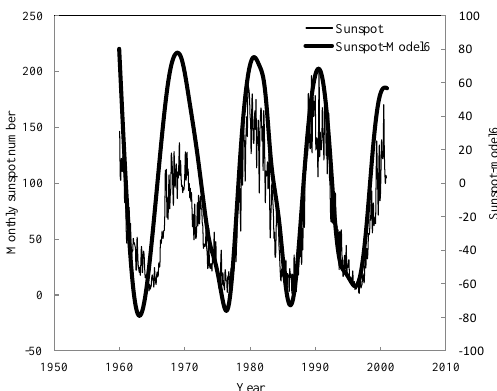
Figure 9. The monthly sunspot numbers and IMF-6 component.